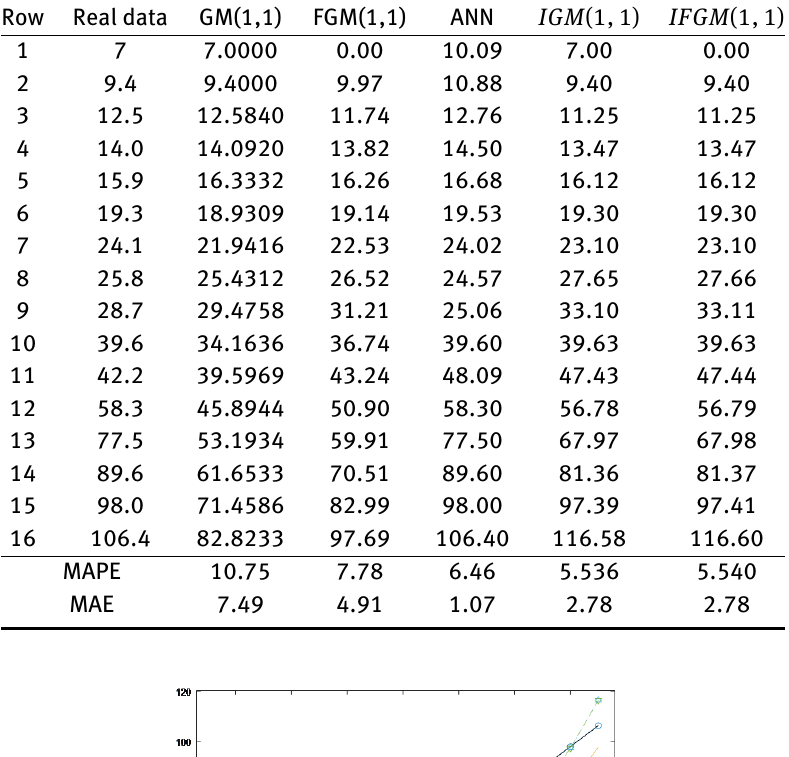
Table 1: The results on the ascending sequence.